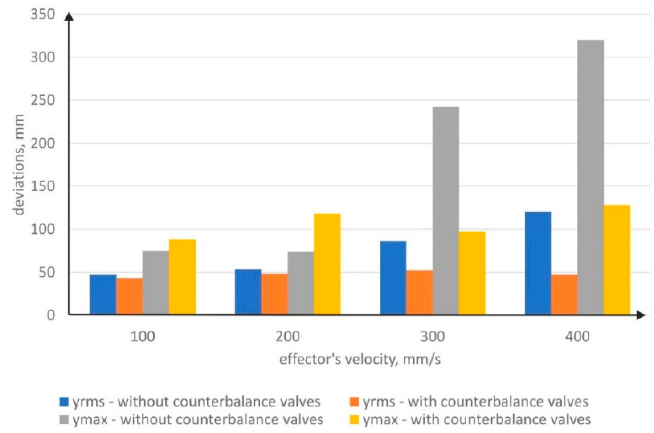
Figure 18. Manipulator effector deviations for different speeds of movement.